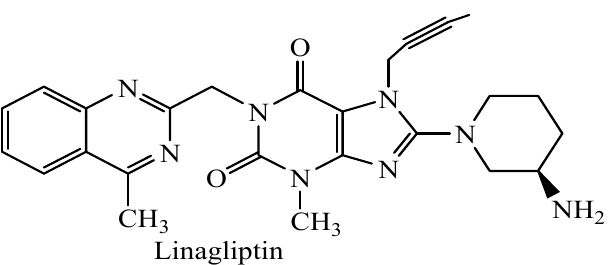
Figure 2. The structure of linagliptin